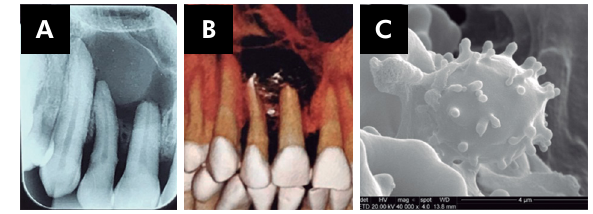
Figure 5. Another case suggesting the presence of a dendritc cell. (A) Periapical radiograph; (B) Dental tomography; (C) SEM at